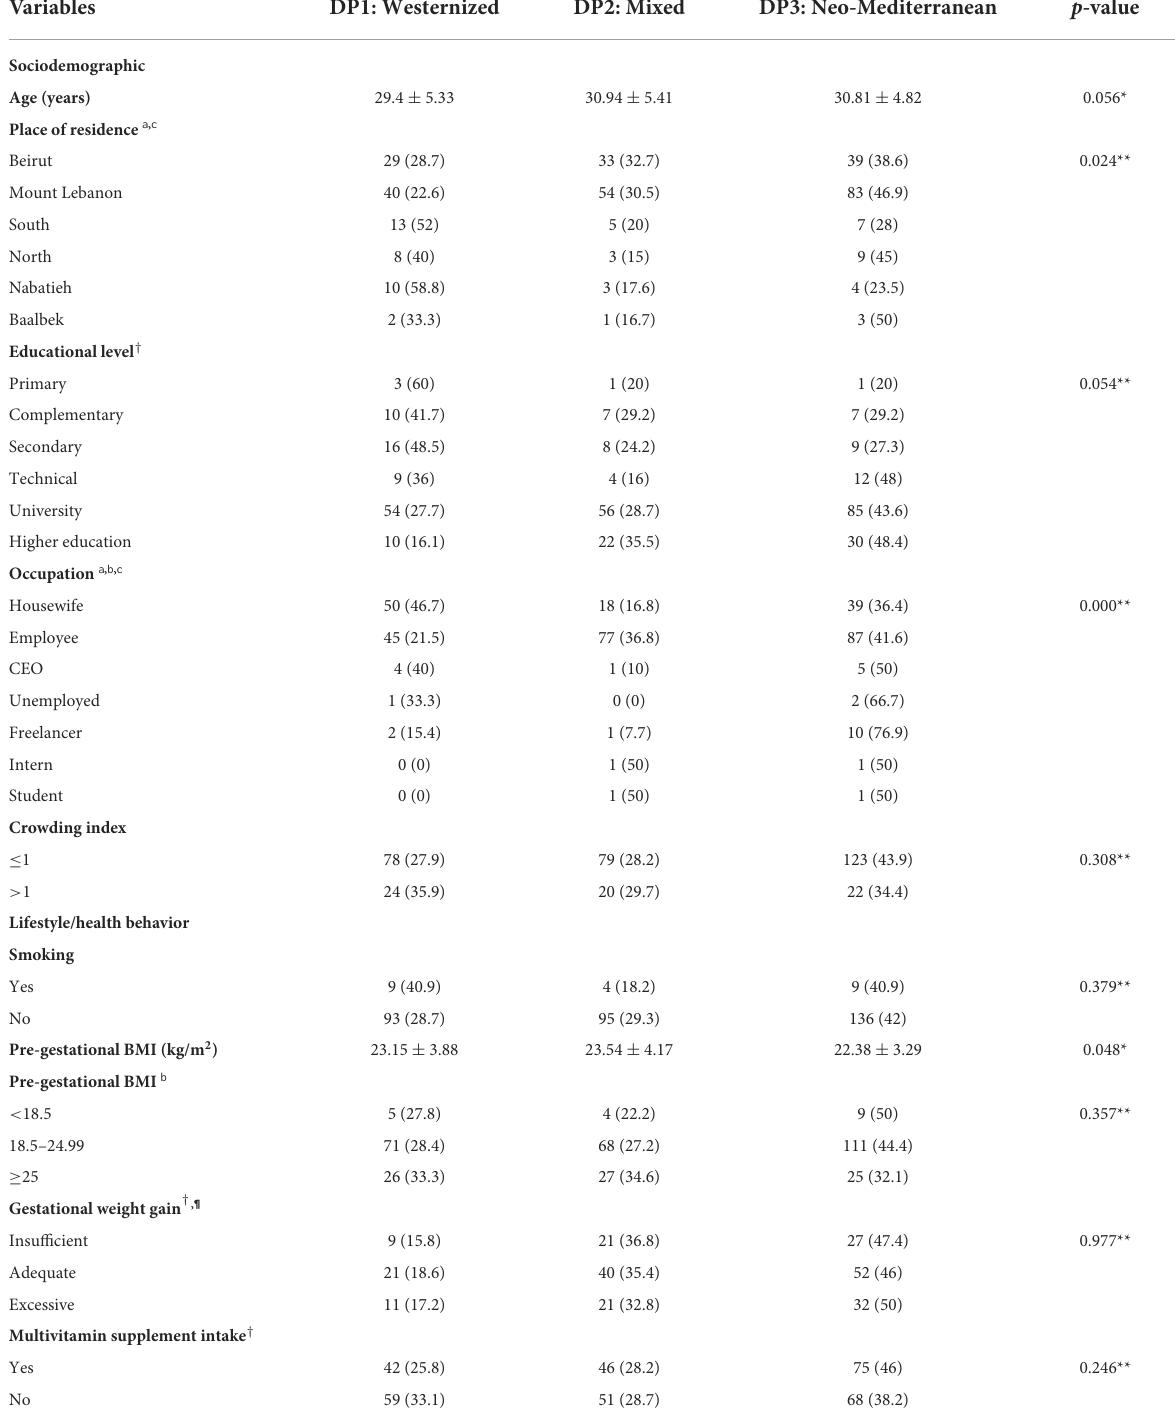
TABLE 5 Sociodemographic, lifestyle and environmental maternal factors and dietary patterns during pregnancy (N = 358 † ). Variables DP1: Westernized DP2: Mixed DP3: Neo-Mediterranean p